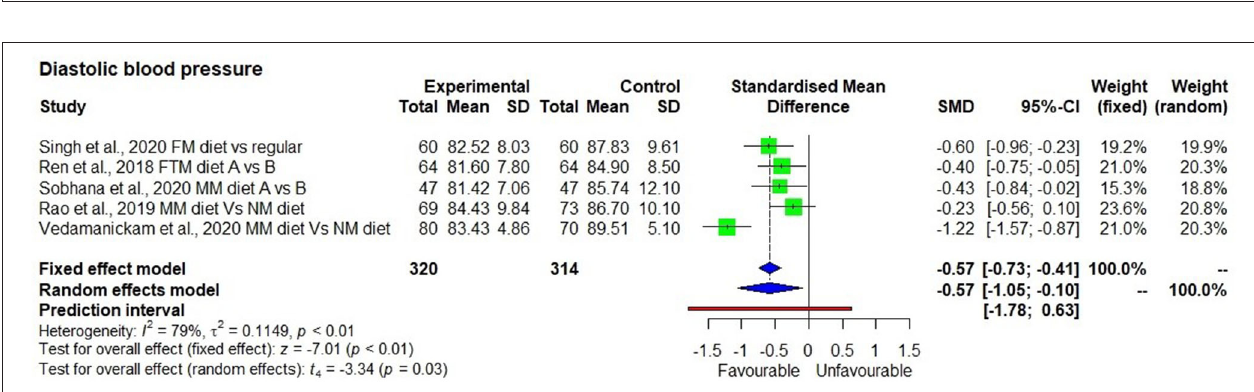
levels, and long-term consumption resulted in efficient millets can help manage LDL-C levels and reduce the risk of